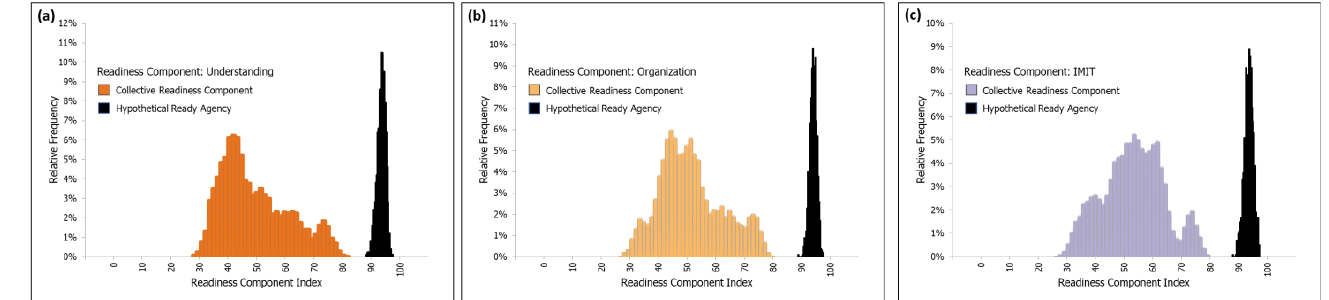
Figure 4. Readiness component index distributions of the collective fire management agencies with the theoretical ready agency scores: ( a ) Understanding, ( b ) Organization, and ( c ) IMIT.